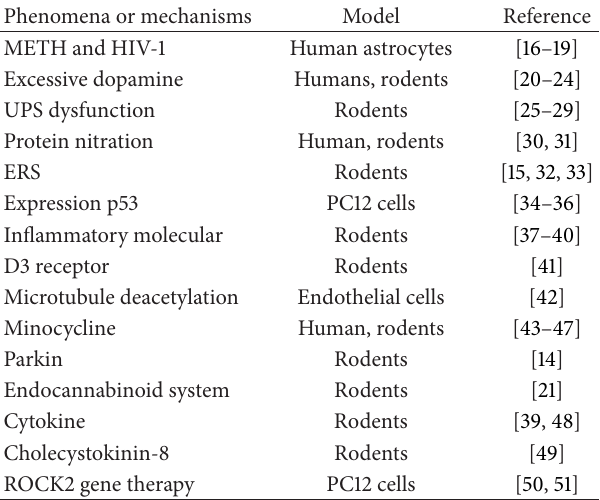
Table 1: A brief summary of some phenomena, mechanisms, or fundamental concepts with studies from humans or from